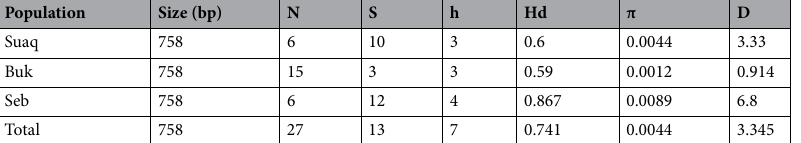
Table 2. Summary statistics on polymorphism of ITS1–5.8S–ITS2 genes in three populations of O. aculeatum collected from orangutans and gibbons inhabiting Borneo and Sumatra. N, Number of Sequences obtained; S, Number of polymorphic sites; h, Number of haplotype; Hd, Haplotype diversity; π, Nucleotide diversity; D, Average number of nucleotide difference between sequences.